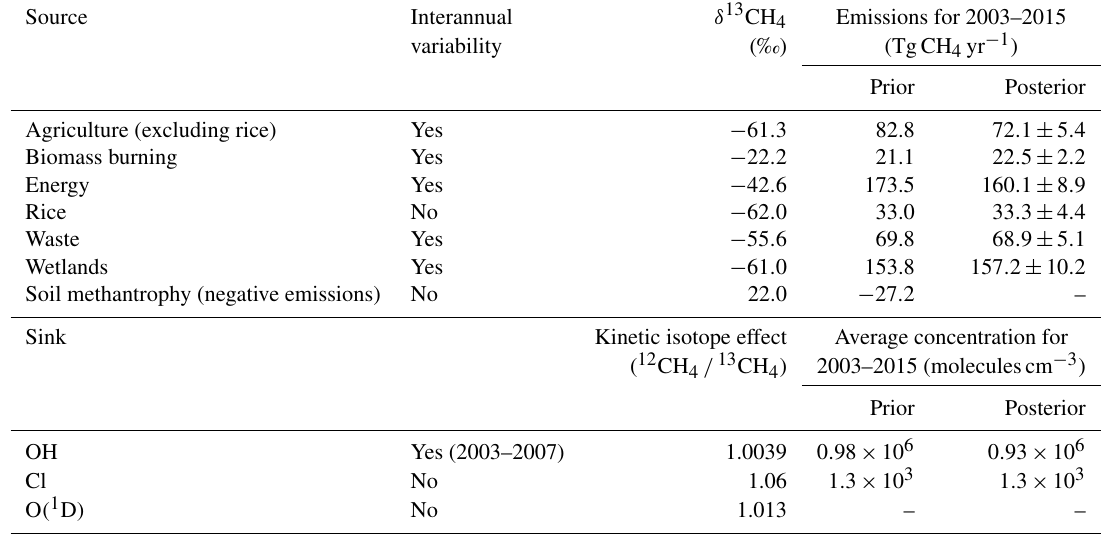
Table 1. Source and sink isotope signatures used in the TOMCAT 3-D CTM. Values for prior emissions (Kirschke et al., 2013; McNorton et al., 2016a; Schwietzke et al., 2016) and isotope signatures (Saueressig et al., 2001; Mikaloff-Fletcher et al., 2004; Feilberg et al., 2005; Whiticar et al., 2007; Schwietzke et al., 2016) are based on previous studies. Note that the soil sink is not optimised and modelled as a negative emission. Posterior emissions estimates are shown with posterior error